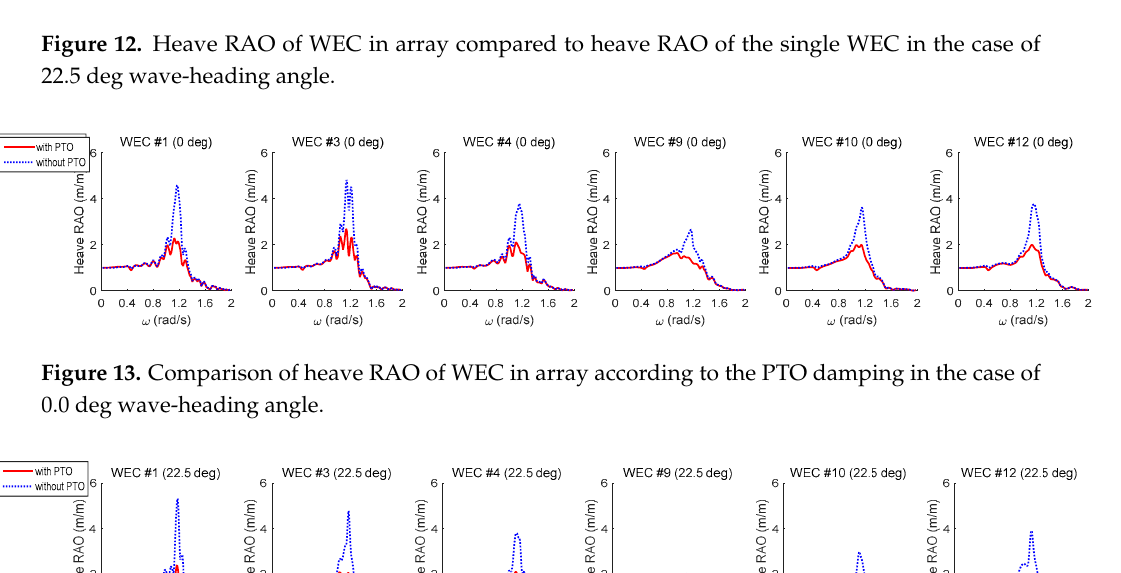
Figure 14. Comparison of heave RAO of WEC in array according to the PTO damping in the case of